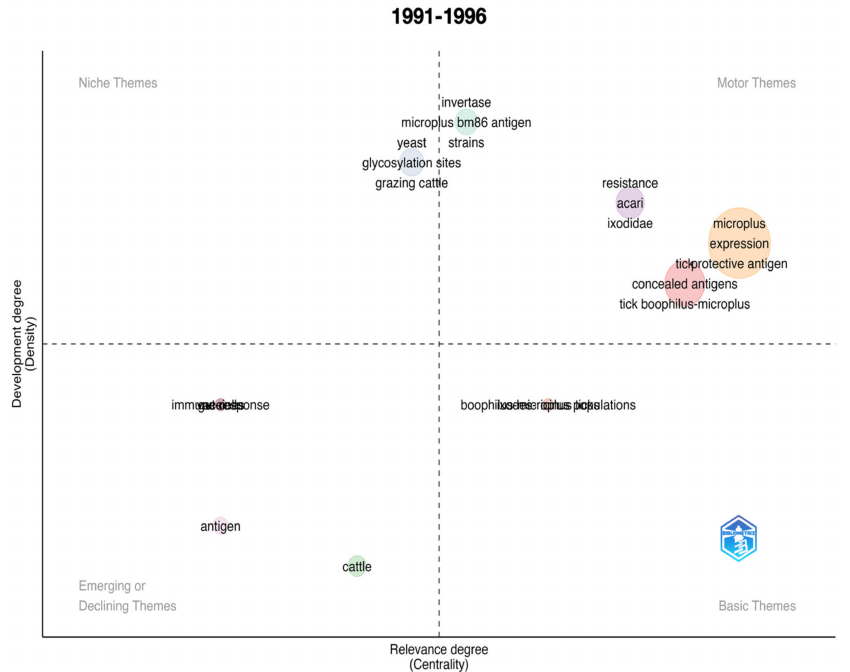
Figure 1. Thematic roles of the documents published on the topic “anti–tick vaccination” and obtained from a query of the literature in PubMed, Scopus, and Web of Science. The meaning of the four quadrants (defined as “themes”) is explained in the Section 2. The figure covers the complete period 1991–2022 and is analyzed in subsequent figures by time slices.